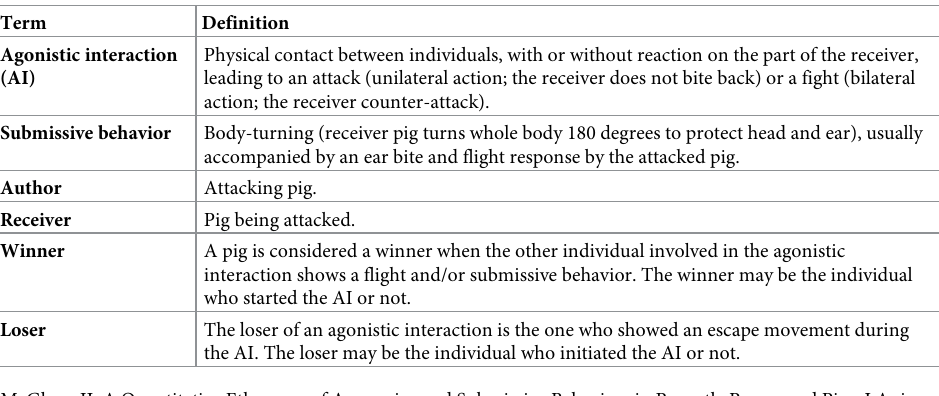
Table 1. Definition of the ethological patterns